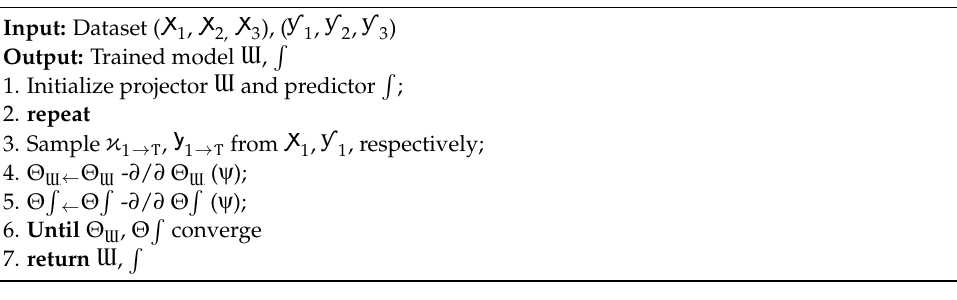
Algorithm 1 Learning Procedure for the Proposed Framework